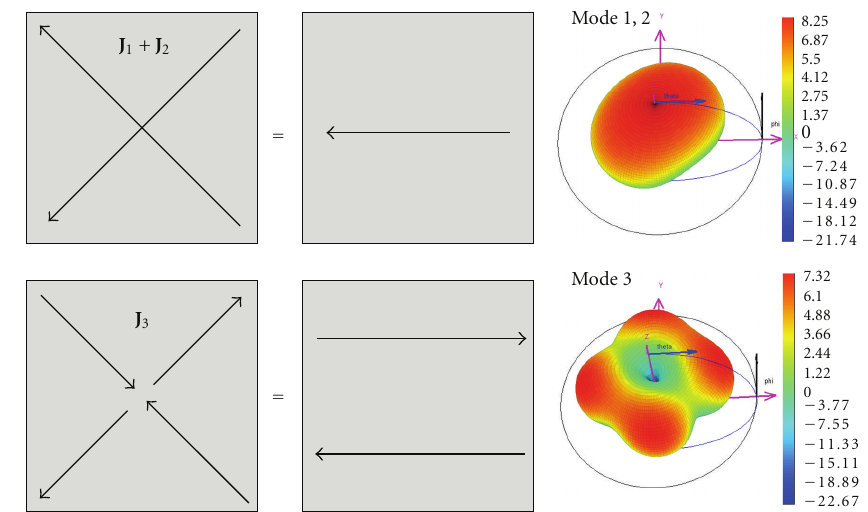
Figure 15: Schematic depiction of the dominant current paths for the dominant ( J 1 + J 2 ) and the second higher J 3 modes together with their modal radiation